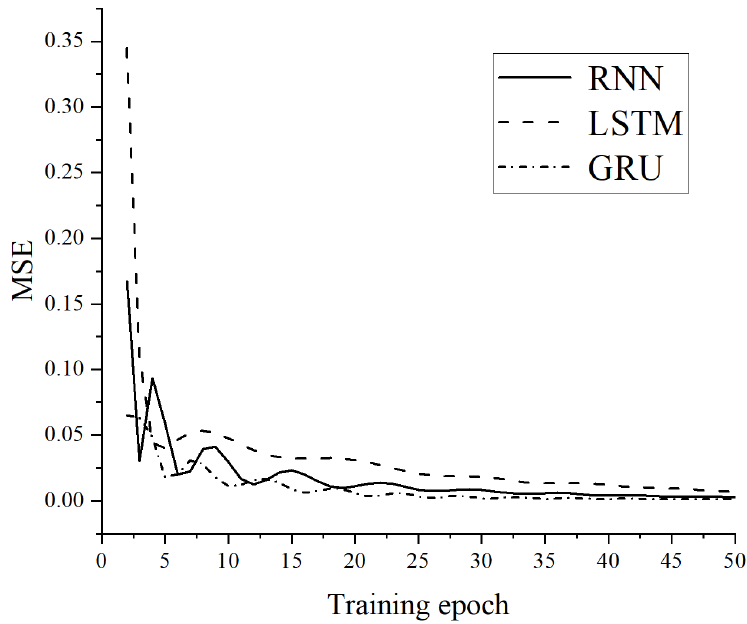
Figure 4. The training process of deep learning models.